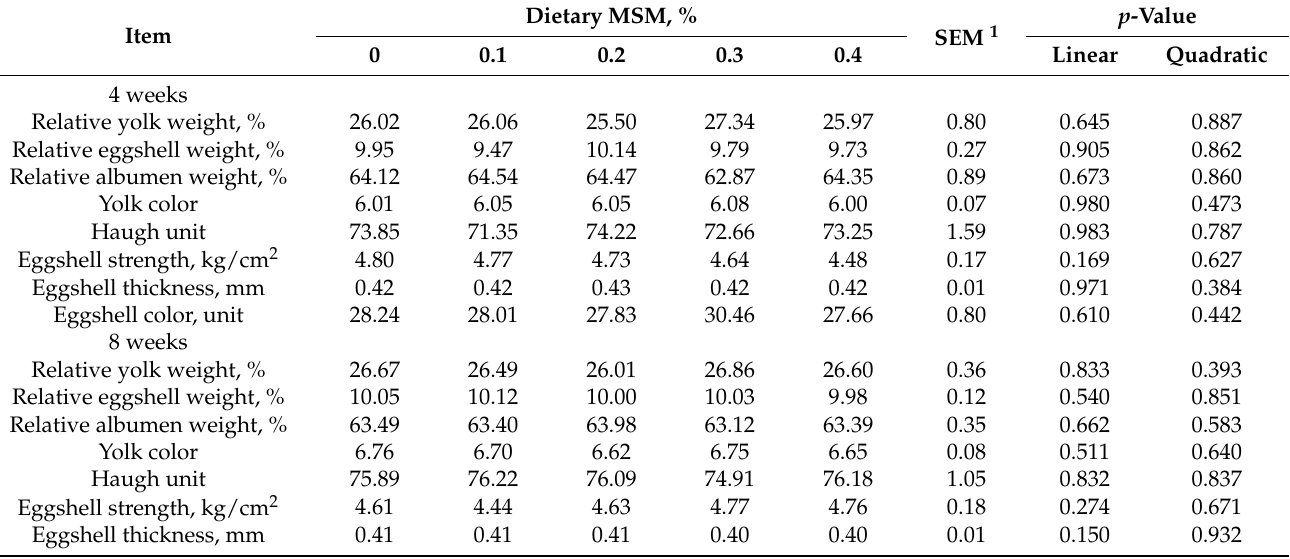
Table 3. Effects of graded levels of dietary methyl sulfonyl methane on the egg components and egg quality from laying